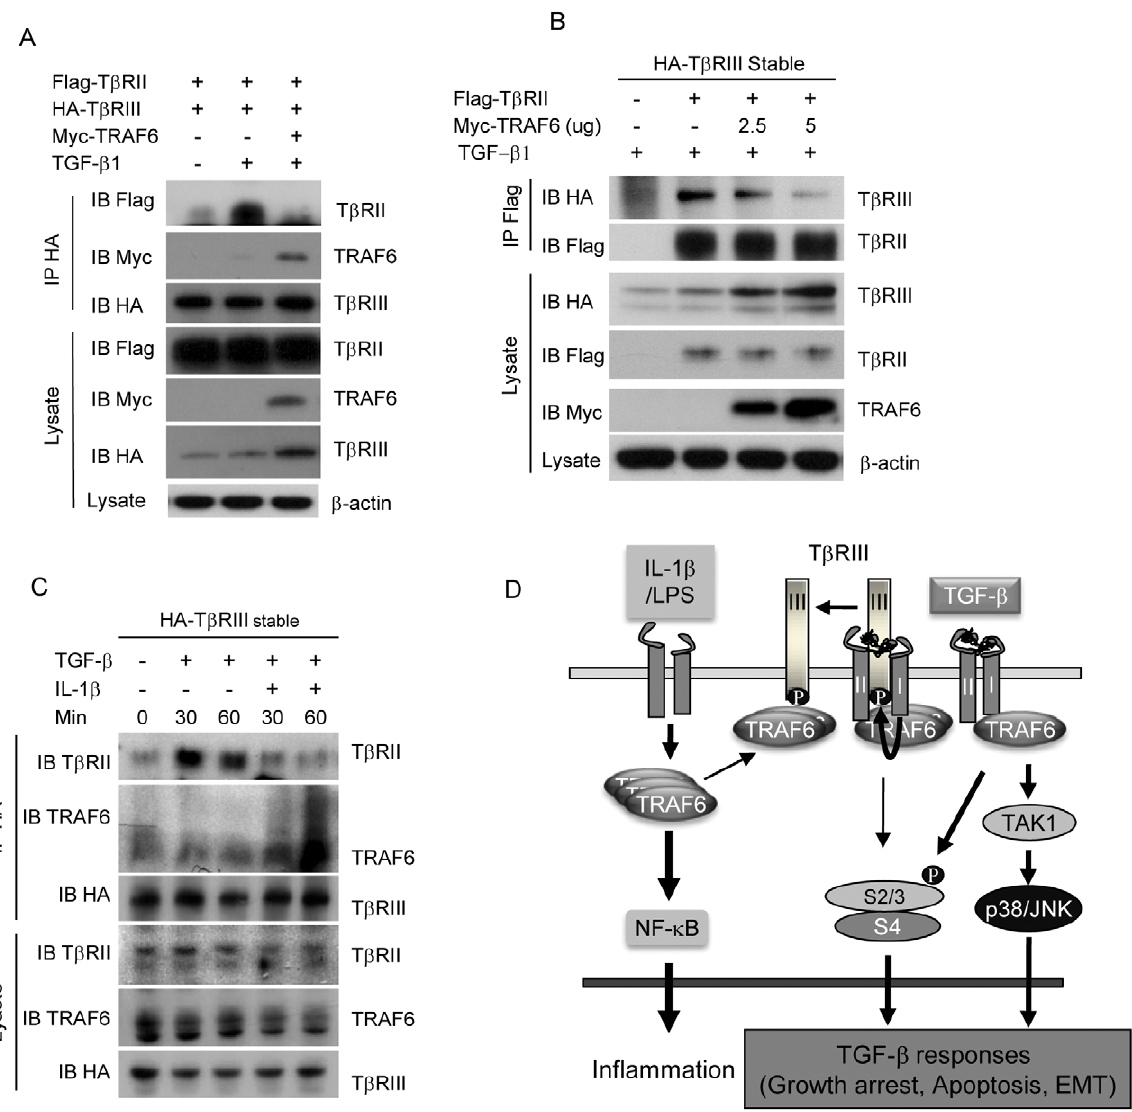
Figure 6. TRAF6 enhances dissociation of T b RIII from T b RII/T b RI complex. ( A ) The interaction between T b RIII and T b RII was enhanced by TGF- b 1, and interfered by TRAF6 expression in HEK293 cells. ( B ) Over-expression of TRAF6 in HEK293 HA-T b RIII-stable cells interfere the interaction of Flag-T b RII and HA-T b RIII in a dose-dependent manner. ( C ) HEK293 HA-T b RIII-stable cells were treated as indicated, and were subjected to immunoprecipitation. HA-T b RIII interacted with endogenous T b RII upon TGF- b 1 treatment. The level of endogenous T b RII bound to HA-T b RIII was markedly decreased in TGF- b 1/IL-1 b co-treated cell, while the level of endogenous TRAF6 bound to HA-T b RIII was increased s. These results are representative of three independent experiments. ( D ) A proposed model of IL-1 b /LPS-induced suppression of the TGF- b